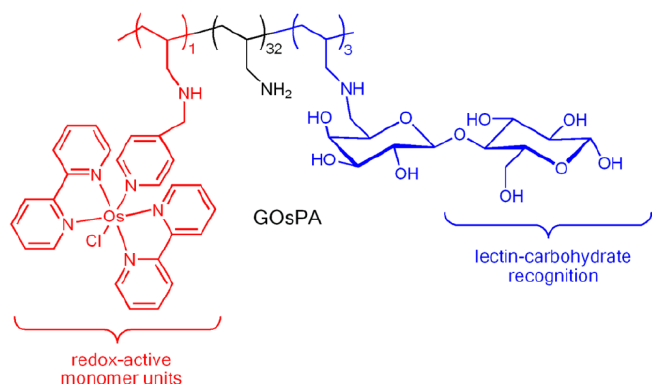
Figure 14. Redox-active glycopolyelectrolyte (GOsPA). Reprinted with permission from [147]. Copyright (2013) American Chemical Society.